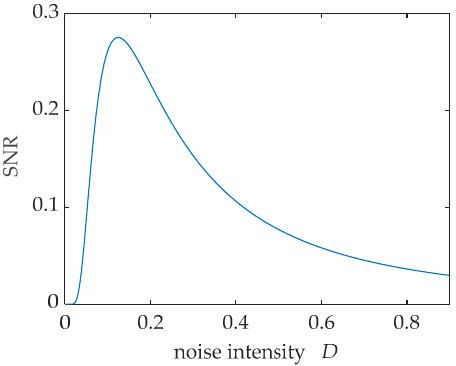
Figure 3. The output SNR versus noise intensity D.